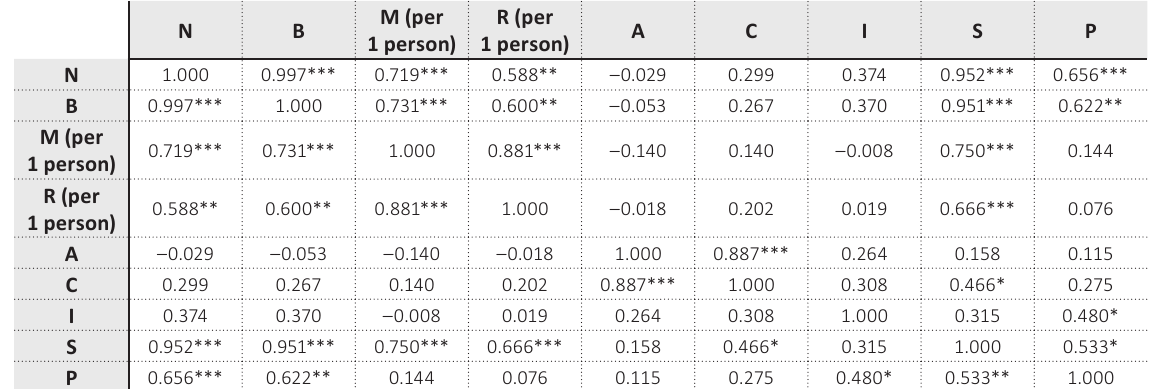
Source: Own processing.